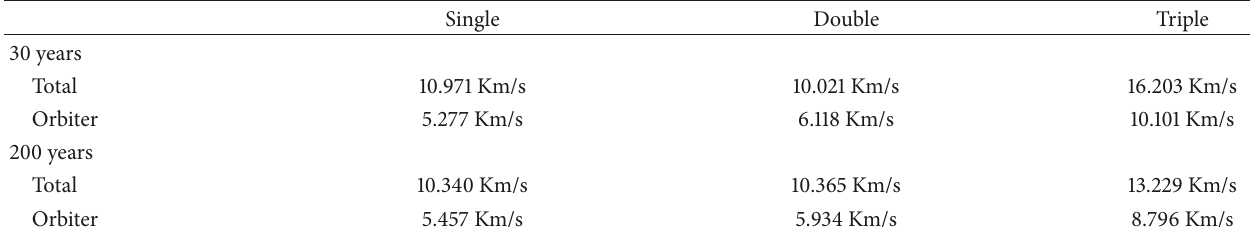
Table 13: Mission total and orbiter Δ𝑉 to Ceres for 30-year time span and 200-year time